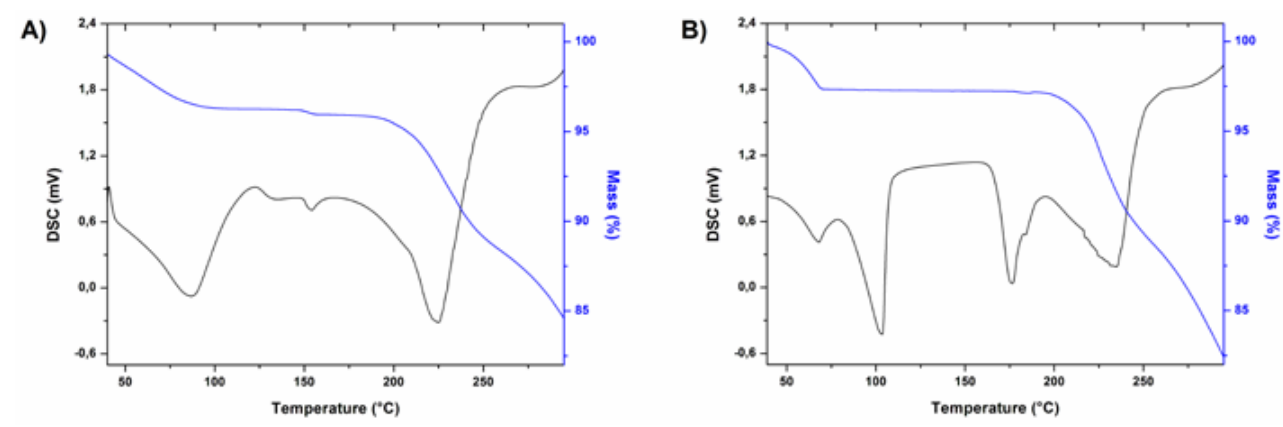
FIGURE 2 - DSC and TG curves of ROSC: A) Amorphous powder; B) Crystalline form